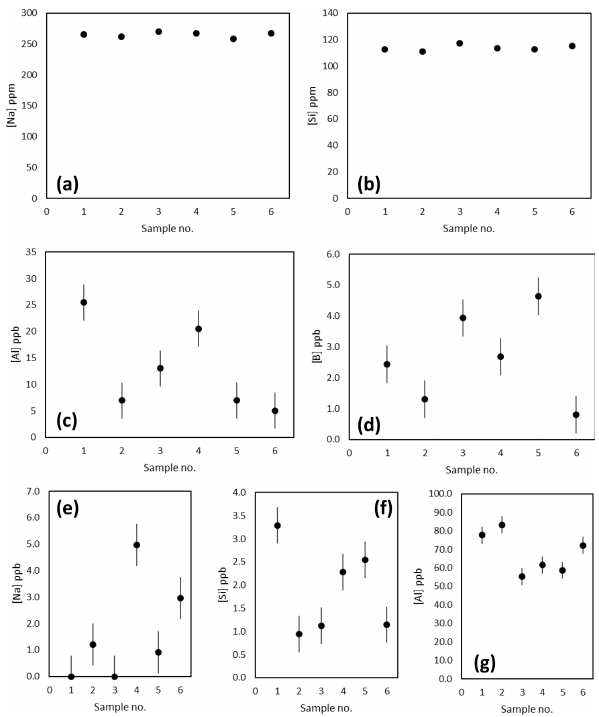
Figure 3. (a–d) Concentration of Na, Si, Al and B in the matrix fraction by ICP-MS. These analyses suggest blank levels of B are present in the matrix washed off the Amberlite IRA 743 resin-based column. (e–f) Concentration of the Na, Si and Al in the boron frac- tion indicating blank levels of Na (ca. 1.7ppb) and Si (ca. 1.9ppb) and a higher concentration of Al (ca. 68ppb) are